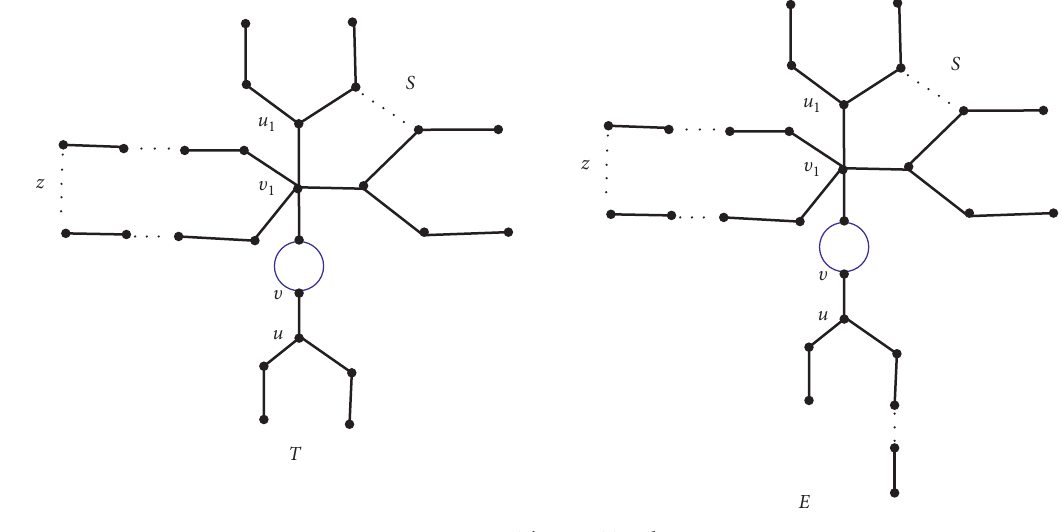
Figure 18: The tree T and E